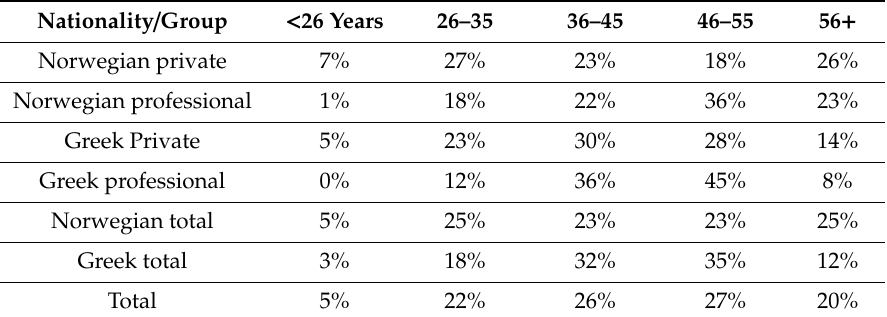
Table 2. Distribution of drivers per group (professional / private) and age.